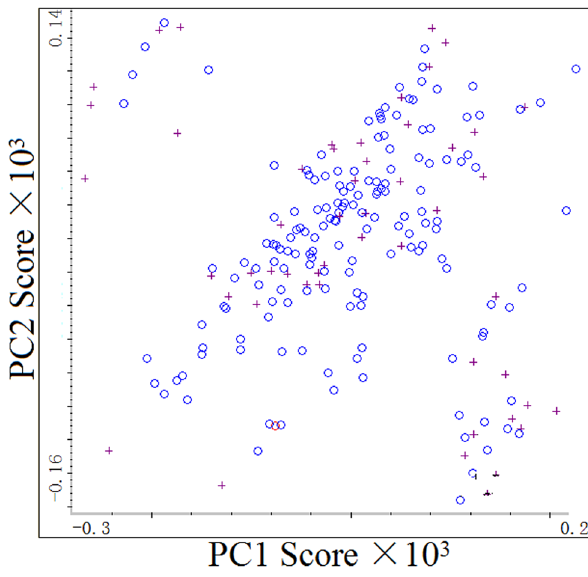
Figure 5: Scatter plot of the fi rst two principal components of the prepreg samples. The blue circle and the red plus represented the calibration set and validation set, respectively.